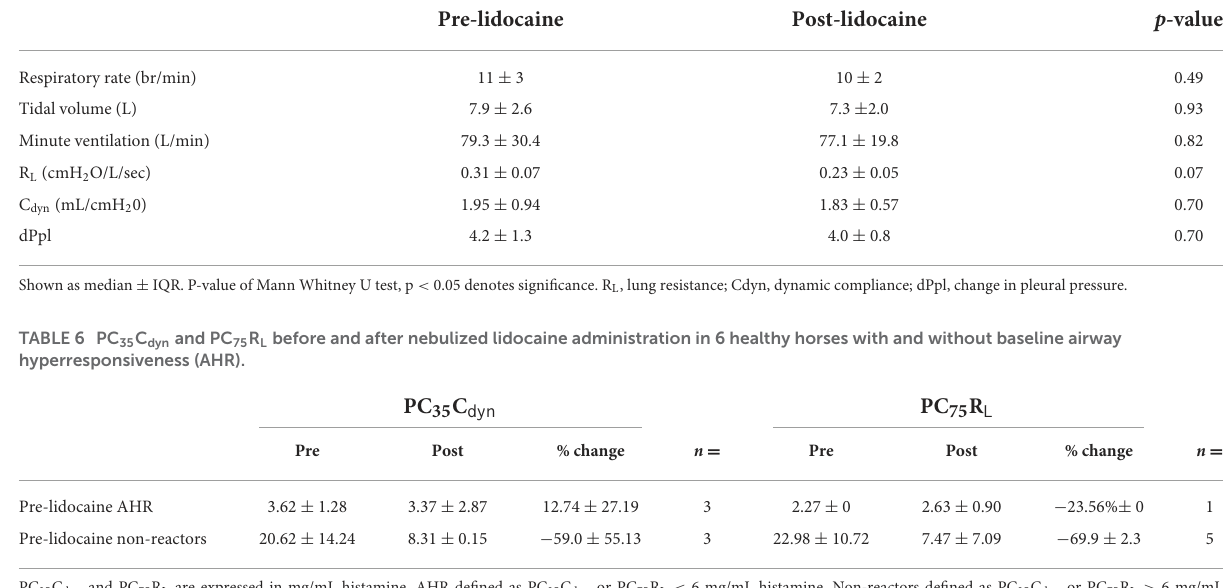
TABLE 5 Spirometry and esophageal balloon data in 6 healthy horses prior to and immediately following nebulization with 1 mg/kg lidocaine. Pre-lidocaine